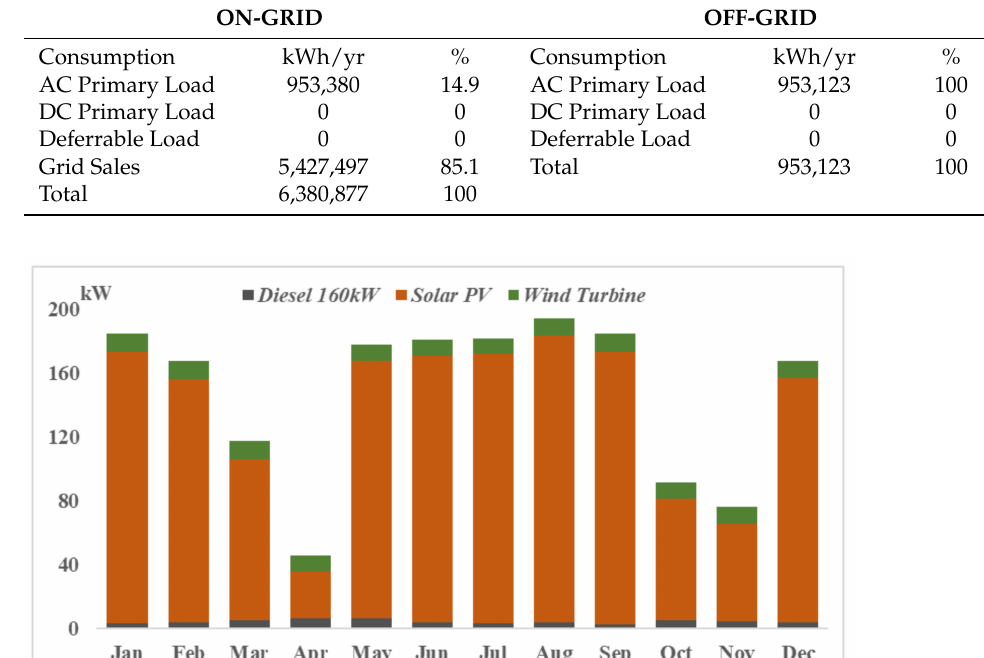
Figure 9. Monthly average electric production for the period of one year.